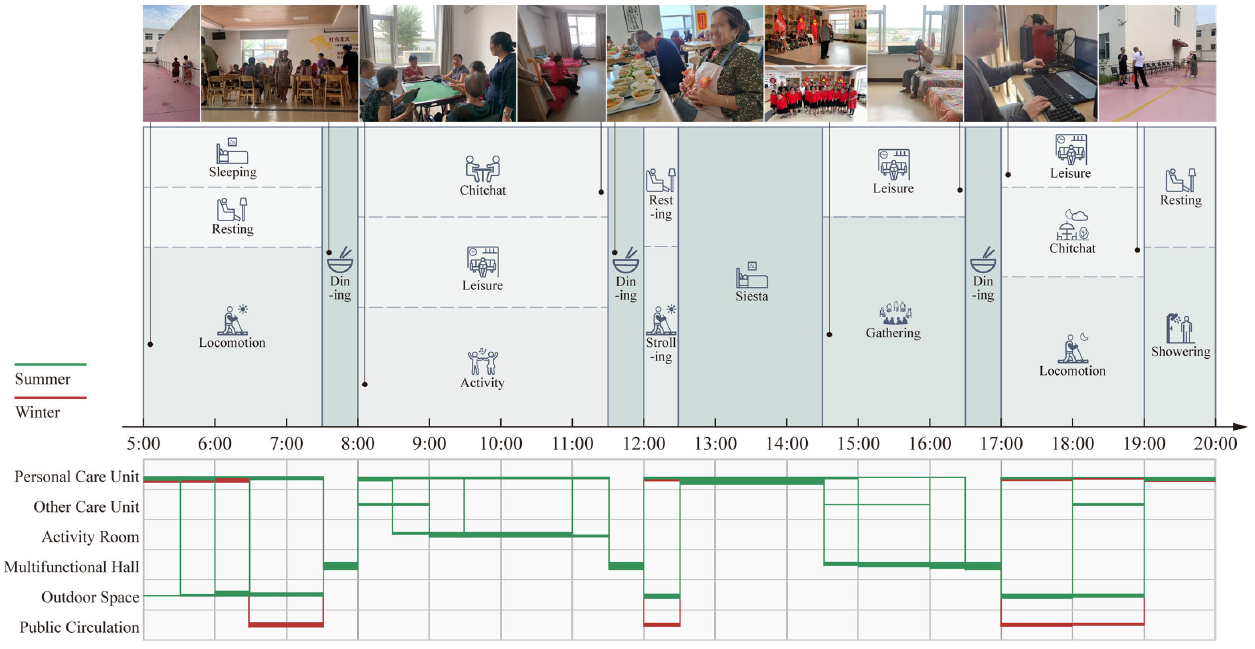
Figure 4. The daily behavior and space utilization of the blind older